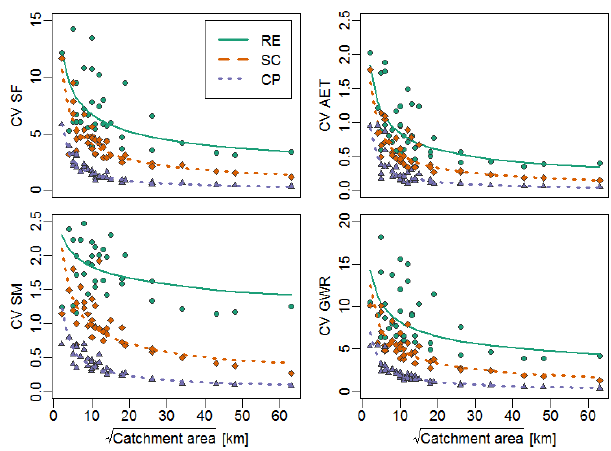
Figure 9. Uncertainty, i.e. coefficient of variation (CV), of hydro- logical states and fluxes at catchments with different sizes (SF is streamflow, AET is evapotranspiration, SM is soil moisture, GWR is groundwater recharge). Exponential curves are fitted to the data. Please note that all figures have individual limits for the y